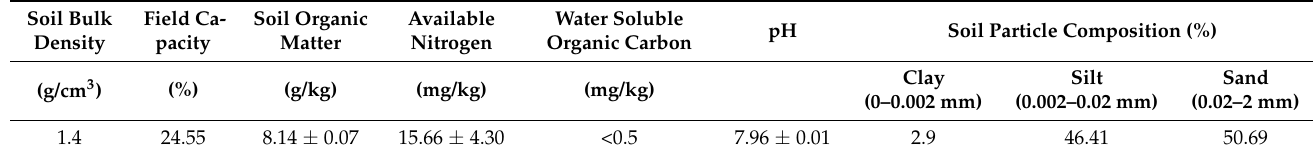
Table 1. The properties of tested soil.